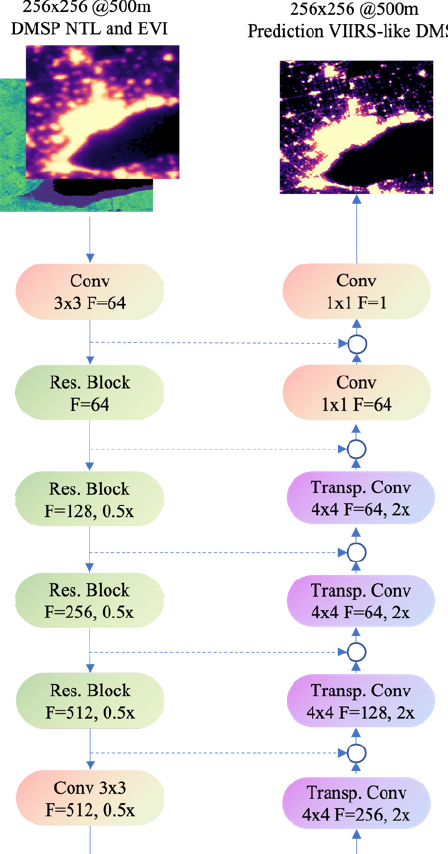
Figure 2 . The proposed deep regression network with DMSP and EVI as input. The dashed lines denote skip connections and circles denote concatenation of channels. F represents the number of